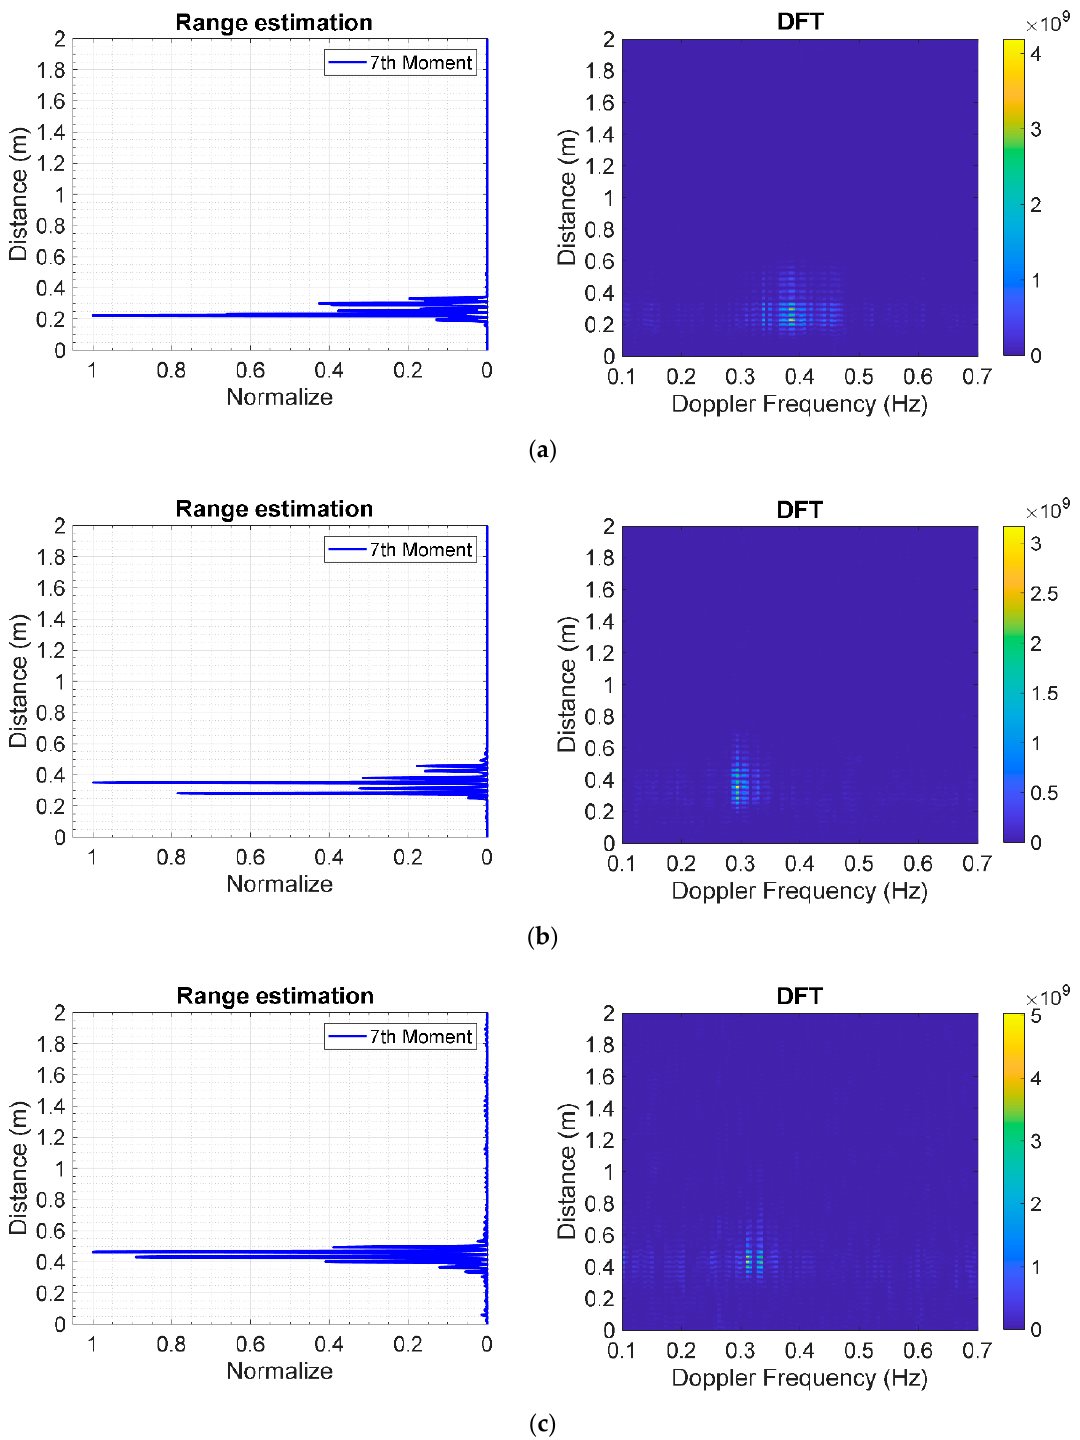
Figure 18. Statistical 7th-moment range estimation of a human subject in supine position under layers of stacked clay bricks using IR-UWB radar system: ( a ) 3 layers (9 cm); ( b ) 6 layers (18 cm); ( c ) 9 layers (27 cm).